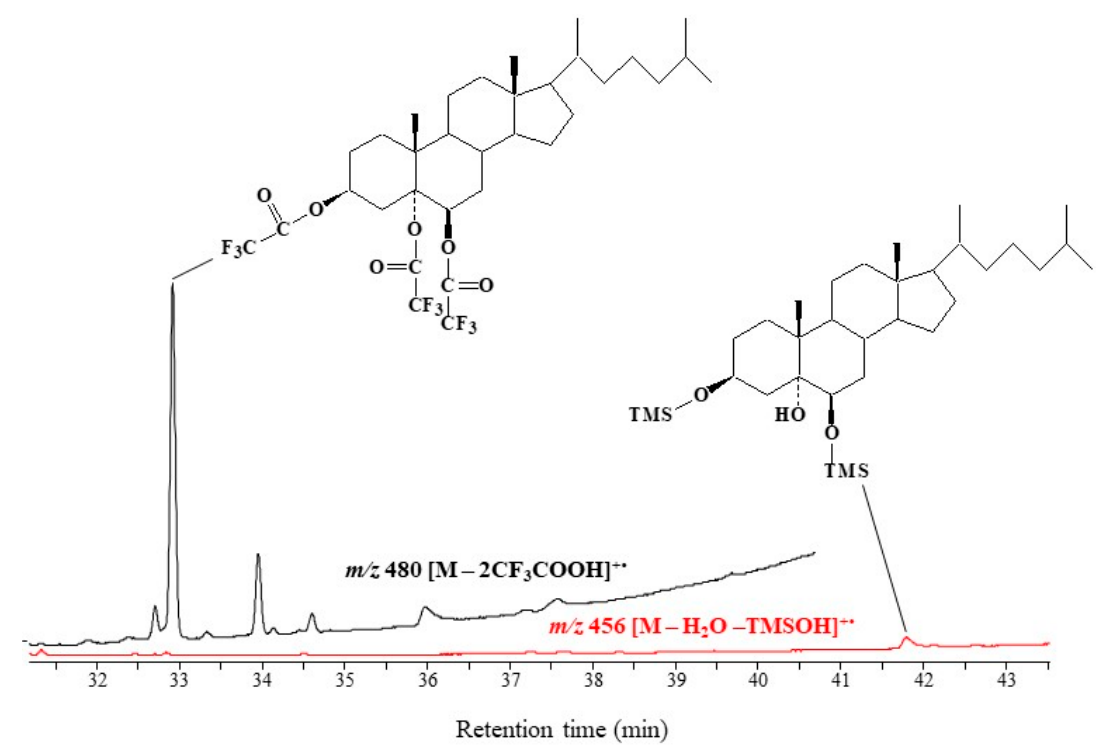
Figure 1. SIM chromatograms of the same amounts (46.5 ng) of trifluoroacetate (black) and trime- thylsilyl (red) derivatives of cholesta-3 β ,5 α ,6 β -triol (• = radical, +• = radical cation). lyl (red) derivatives of cholesta-3 β ,5 α ,6 β -triol ( • = radical, + • = radical